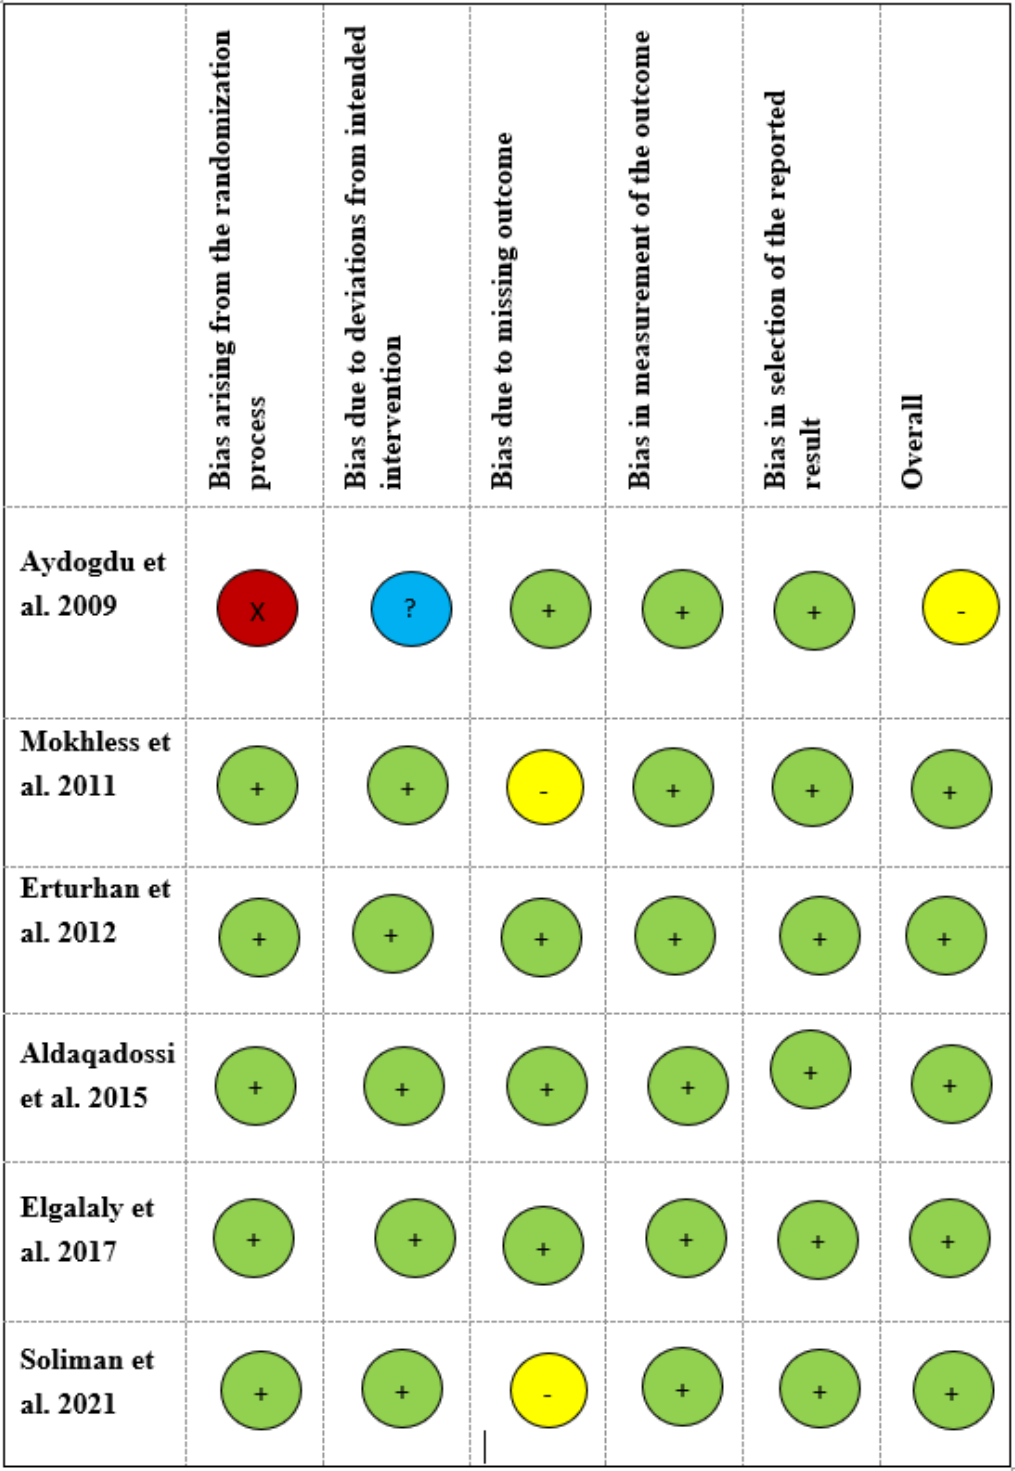
Figure 2. Risk of bias in included studies. A green circle indicates a low, a yellow circle indicates a moderate, a red circle indicates a critical, and a blue circle indicates an unknown level of bias